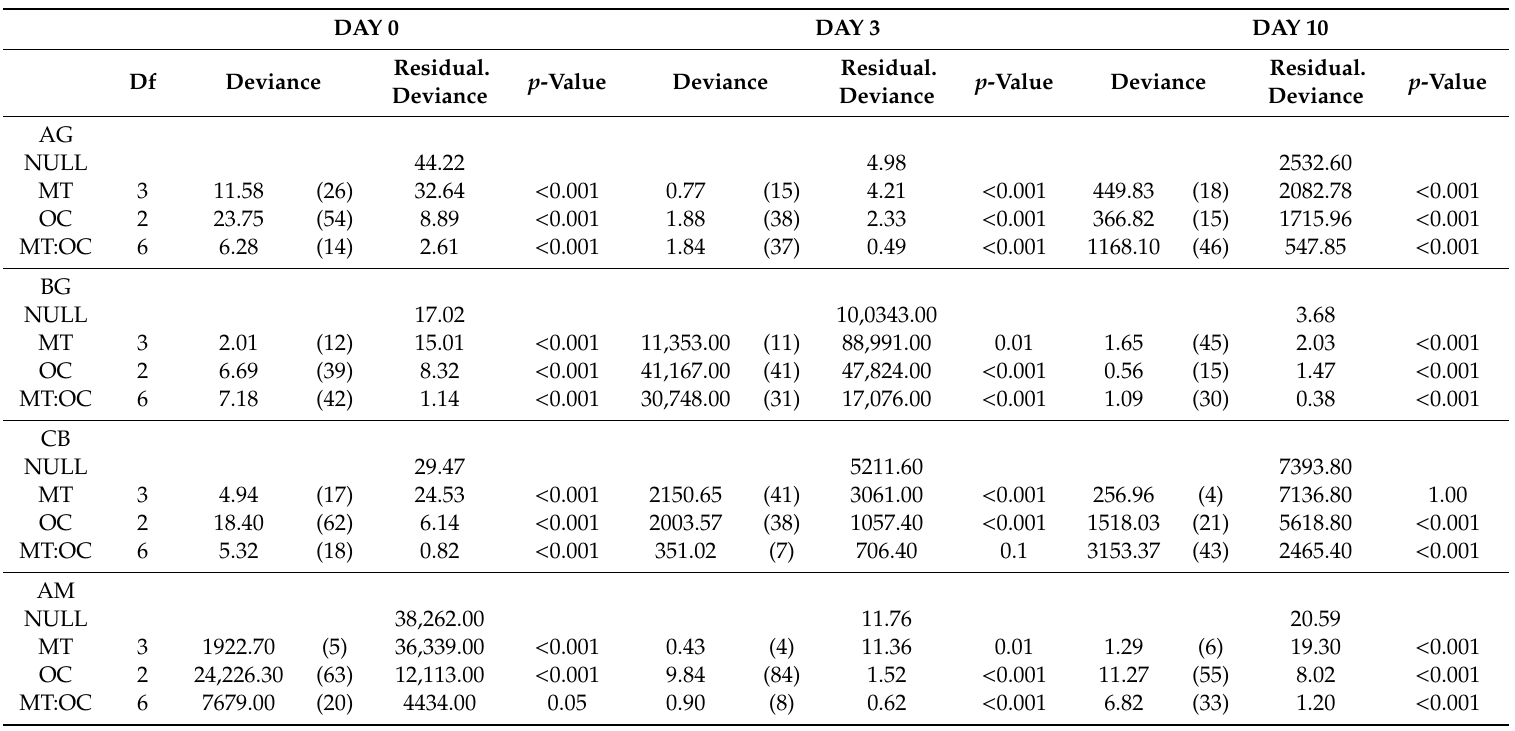
Table 2. Summary of the GLM results for the di ff erences in potential enzyme activities (pEA) due to added montmorillonite (MT), OC (starch or cellulose), and their interactions (MT:OC) over the period of the incubation experiment. Significance was assessed using likelihood ratio tests. Numbers in bracket indicate the percentage of variation explained by the respective